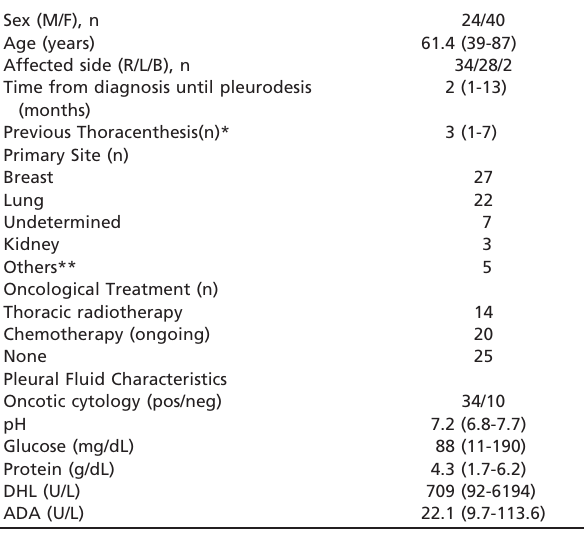
Table 2 - Clinical Effectiveness and Additional Pleural